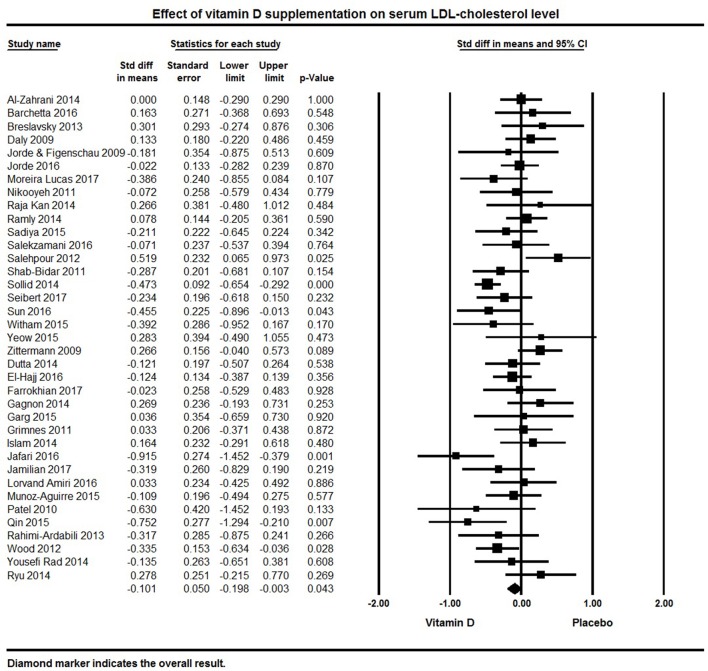
Forest plot detailing standardized mean difference for the impact of vitamin D on serum LDL-cholesterol level.